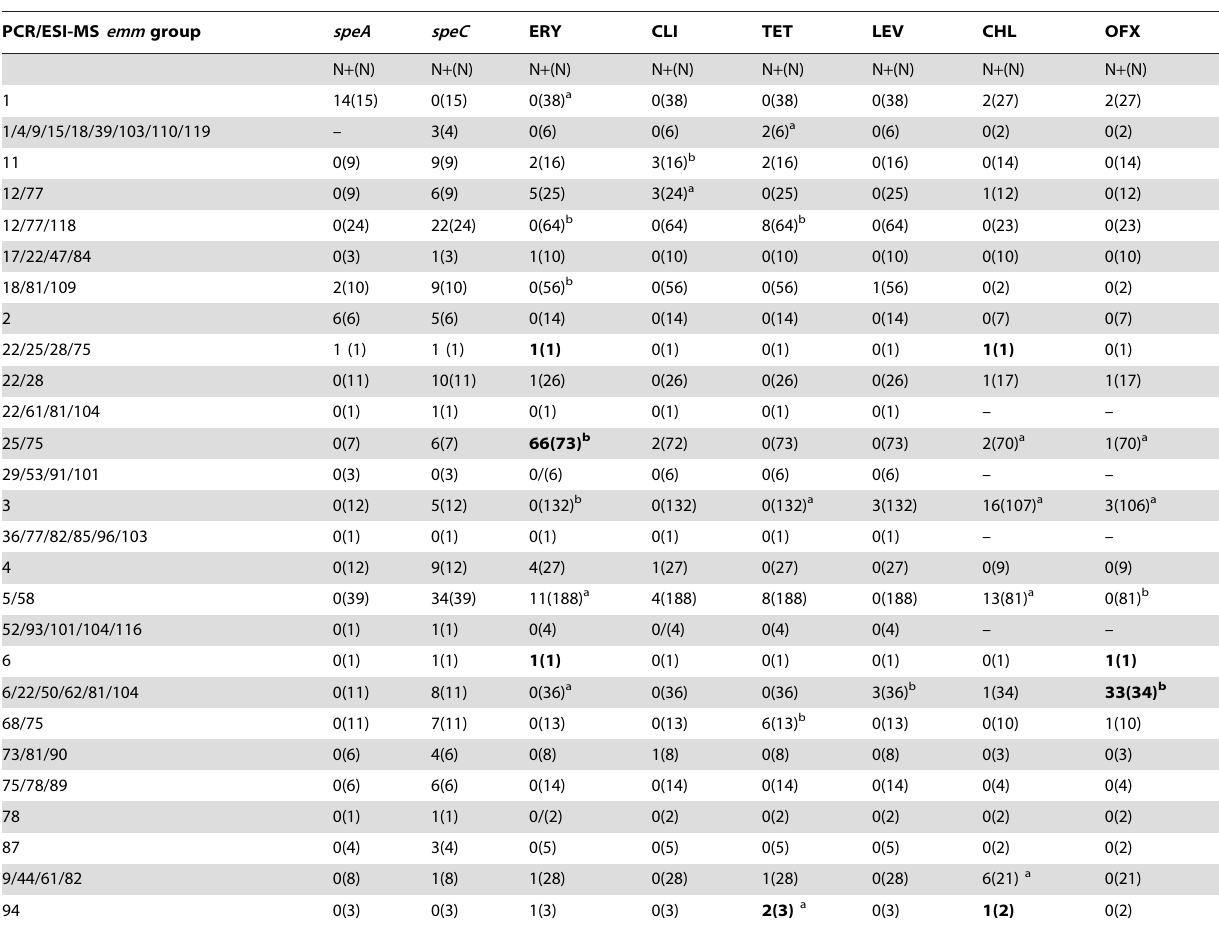
Table 4. Isolate properties by PCR/ESI-MS emm group.